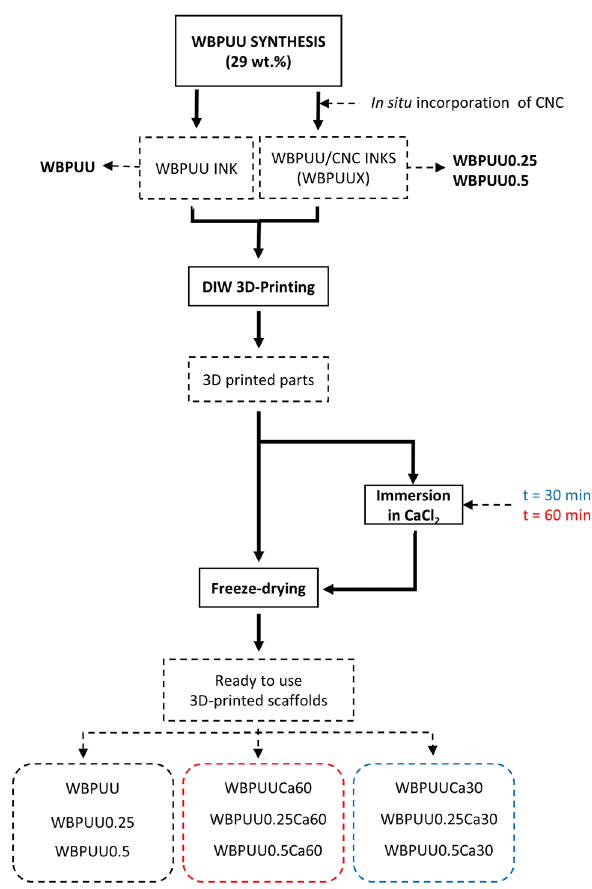
Figure 1. Flow chart of the experimental procedure for the preparation of 3D-printed scaffolds.